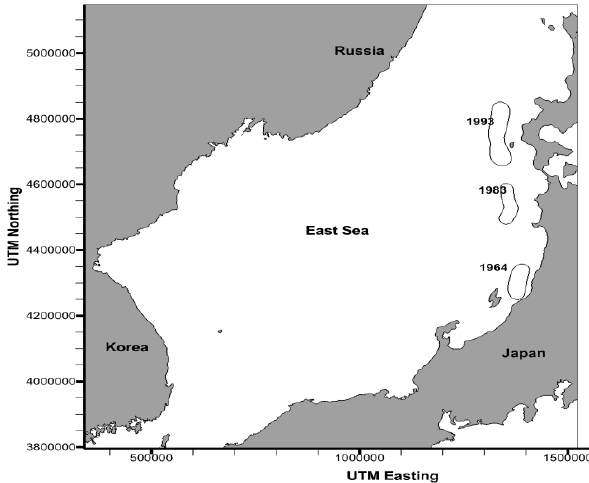
Figure 1. Locations of three historical tsunamis.